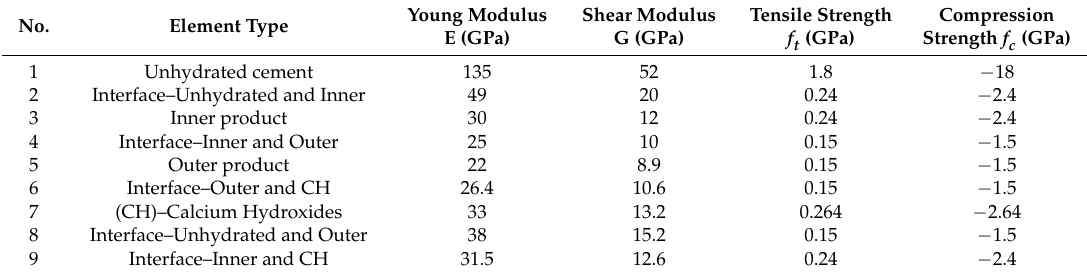
Table 2. Specifications of the lattice model inputs used in the simulation of cement paste (from [41]).